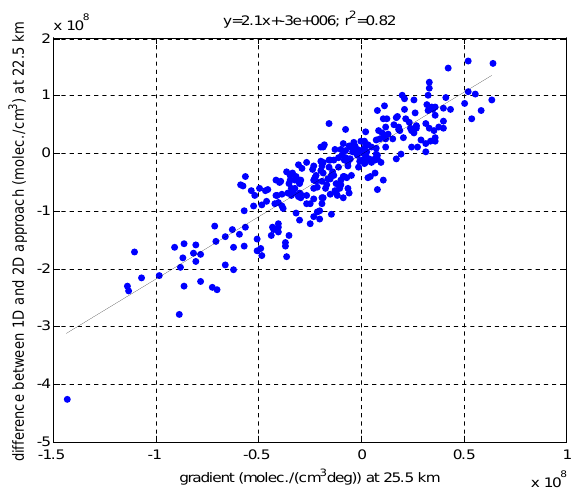
Fig. 8. Difference between the number density retrieved by the 1-D and 2-D approaches at 22.5km as function of the horizontal gradi- ent of the number density at 25.5km as observed for the 2-D re- trieval for all measurements of the full limb orbits on 14 December 2008. Also shown is the line of the best fit to the observed differ- ences. Equation for the line of the best fit and squared correlation coefficient r 2 are provided in the title.